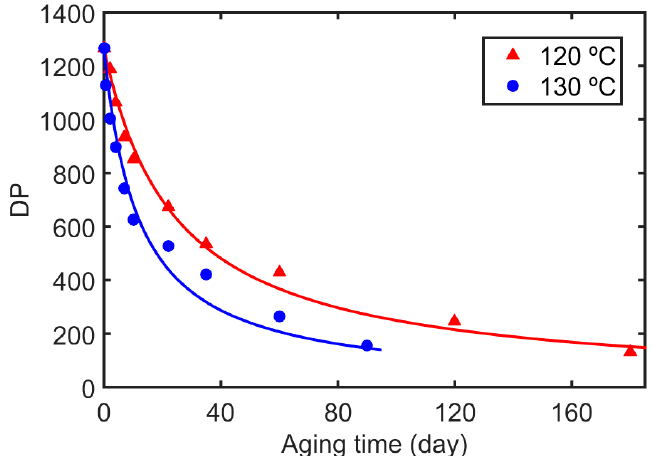
Figure 8. DP of aged paper.